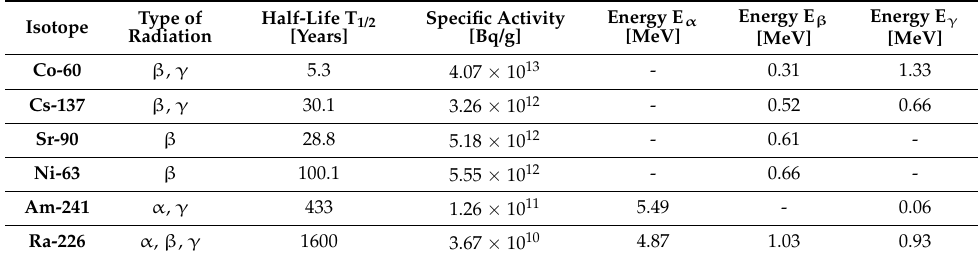
Table 1. Parameters of ionizing radiation sources. Copyright permission from